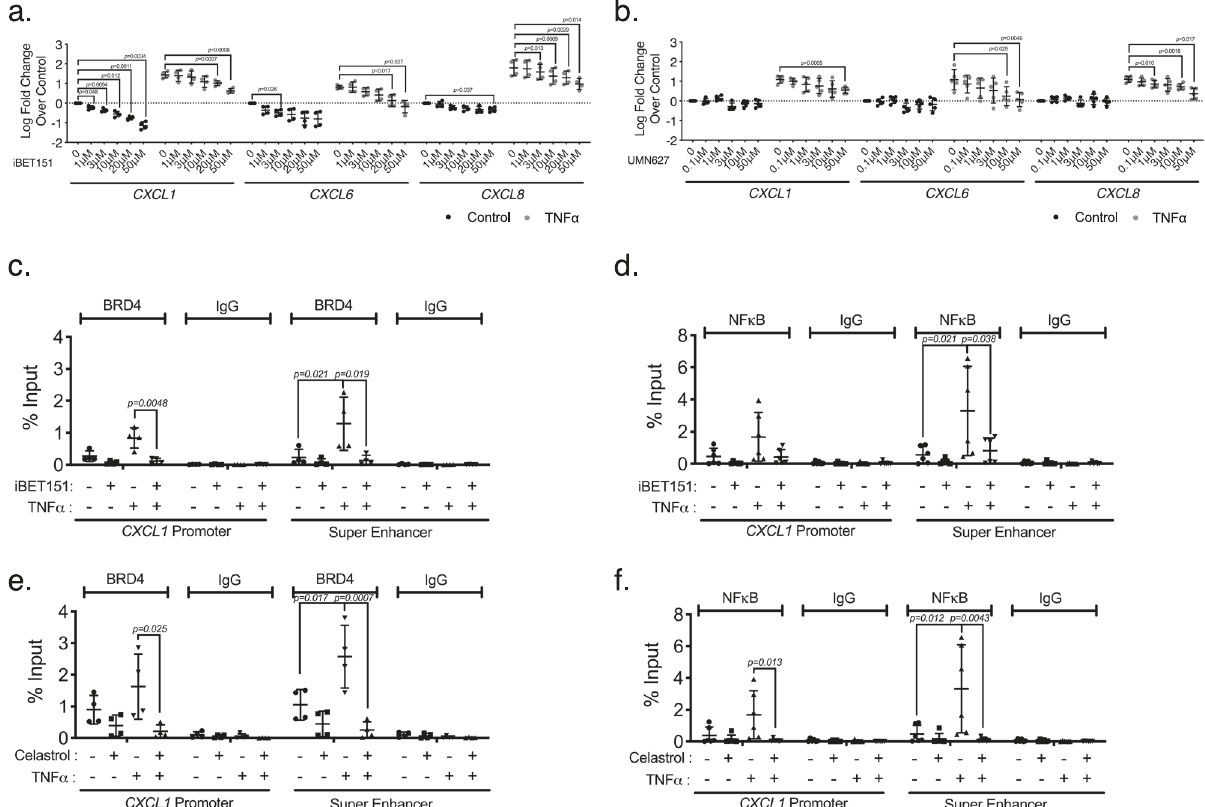
Fig. 5 Bromodomain inhibitors suppress the expression of CXCLs by inhibition of transcription factor binding at CXCL super-enhancer and promoter sites. a , b LSECs were pretreated with iBET151 (0 – 50 μ M) ( n = 4, biologically independent samples from two independent experiments) ( a ) or UMN627 (0 – 50 μ M) ( n = 5, biologically independent samples from three independent experiments) ( b ). CXCL1 , 6 , and 8 expression levels were assessed by qPCR. Expression levels were normalized to basal conditions and log 10 fold change values were plotted. One-way matched-pairs ANOVA analysis was performed with post hoc Dunnett ’ s multiple comparison correction. Data represented as mean ± SD. c , d ChIP-qPCR assays for BRD4 binding ( c , n = 4, biologically independent samples from two independent experiments) or NF- κ B binding ( d , n = 6, biologically independent samples from three independent experiments) with and without TNF α stimulation was assessed at CXCL super-enhancer and CXCL1 promoter sites after pretreatment with iBET151. One- way ANOVA analysis was performed with post hoc Tukey ’ s multiple comparison correction. Data represented as mean ± SD. e , f Same experiments were repeated with Celastrol ( e , n = 4 biologically independent samples from two independent experiments; f , n = 6 biologically independent samples from three independent experiments). Enrichment for either CXCL1 promoter or CXCL super-enhancer sequence was examined. Sequence enrichment was normalized to input. One-way ANOVA analysis was performed with post hoc Tukey ’ s multiple comparison correction. Data represented as mean ± SD. There were signi fi cant linear trends of decreasing CXCL1 , 6 , 8 expressions with increasing iBET151 and UMN627 concentrations without and with TNF α , and with increasing iBET151 concentrations without TNF α ( p < 0.0001 for all groups). All data were repeated at least three times with similar